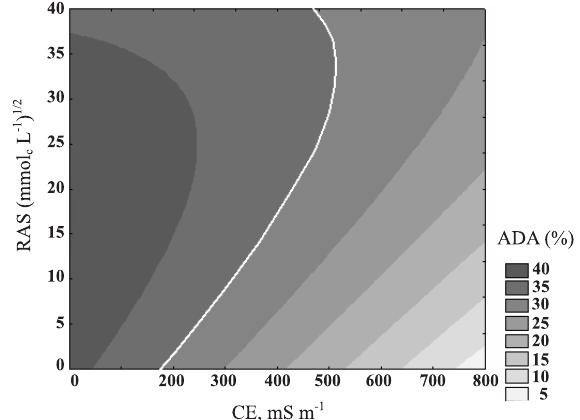
Figura 3. ADA-S em função da RAS e da CE da solução de saturação e de percolação no solo LVd (gibbsítico), apresentando, como detalhe, curva de ADA-A obtida em amostra